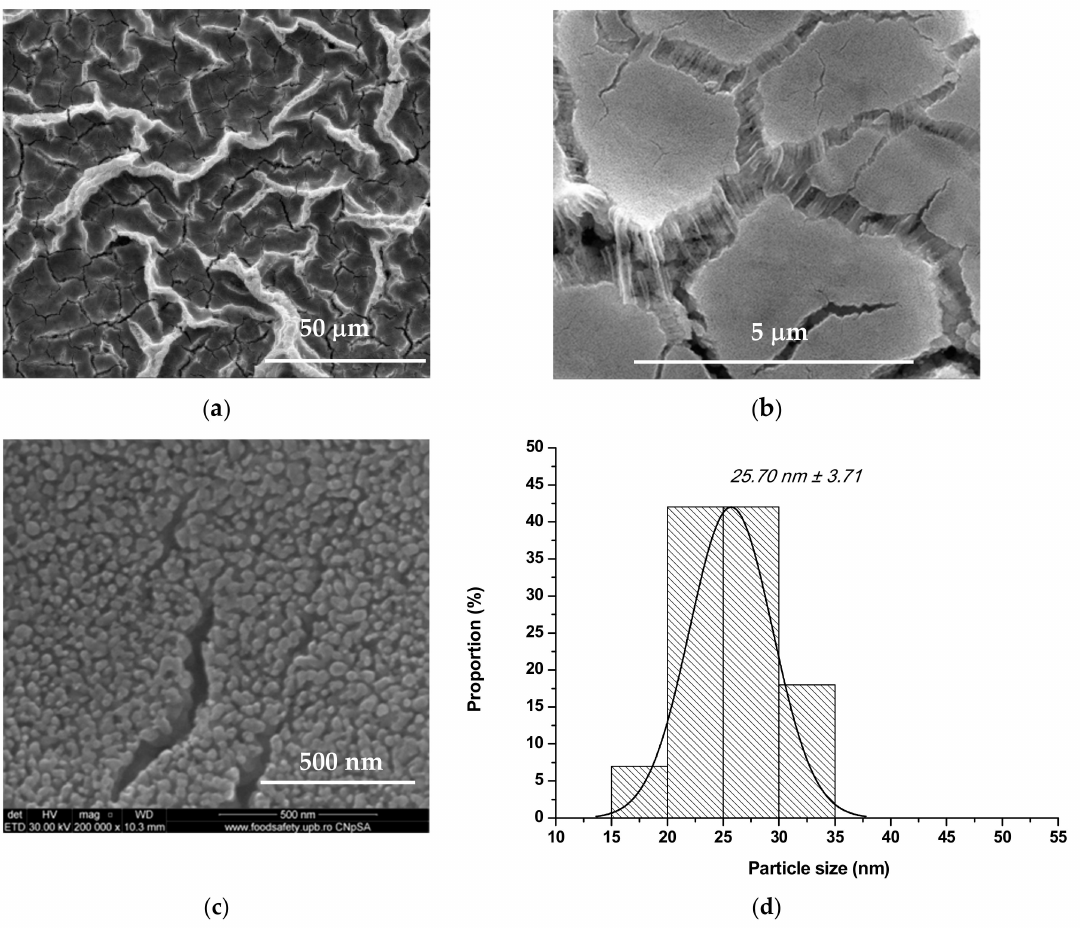
Figure 5. SEM images ( a – c ) and grain size distribution ( d ) for Mg 2 + -doped ZnO